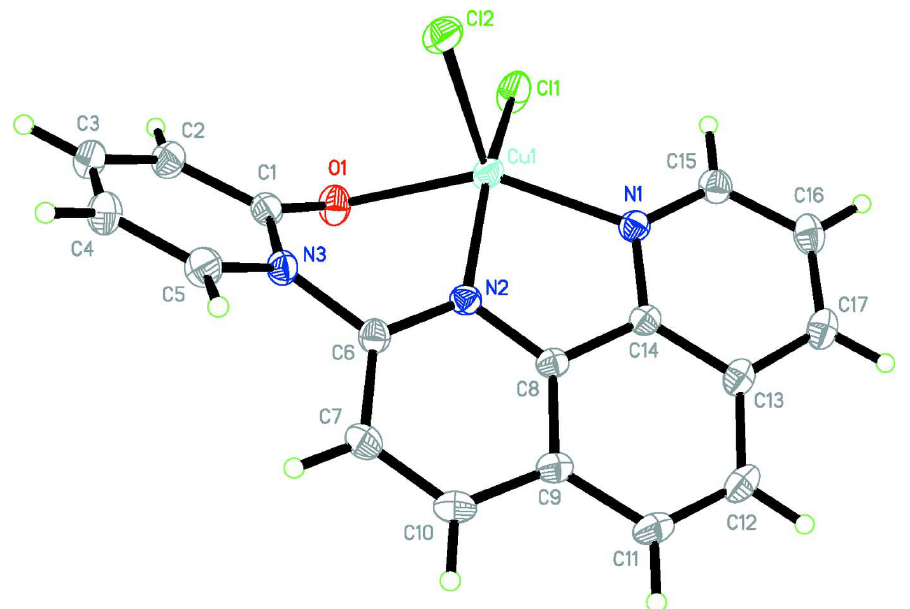
The molecular structure of the title complex with atom-numbering scheme. Displacement ellipsoids are shown at the 30% probability